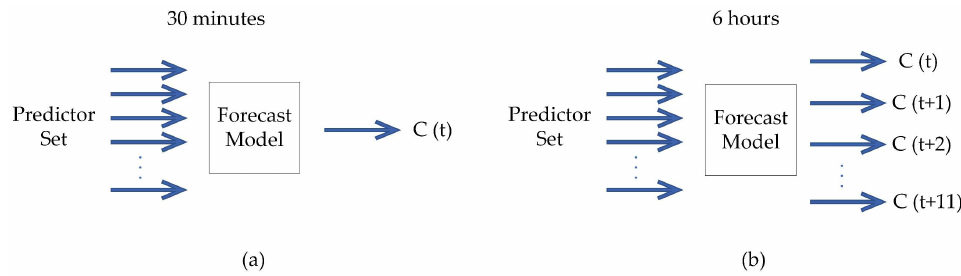
Figure 4. Predictive models for MLP and LSTM networks with a horizon of ( a ) 30 min and ( b ) 6 h.